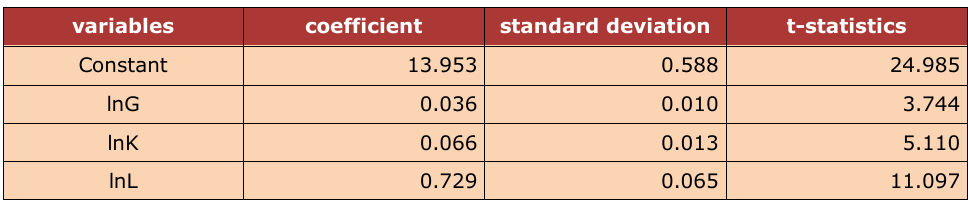
Table 3. Estimated coefficient of listed companies in transportation and storage industry